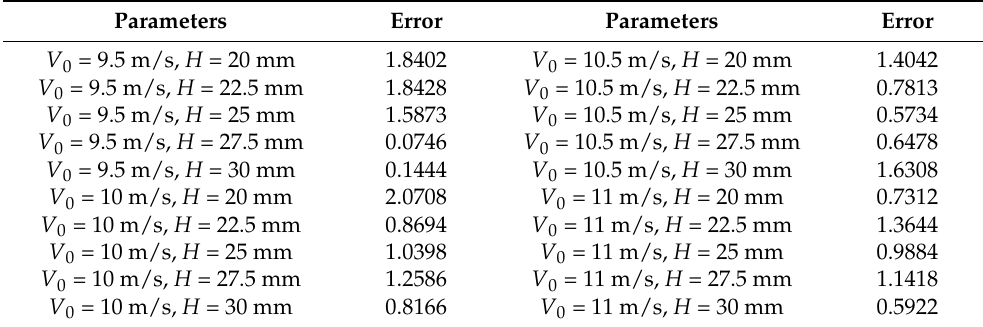
Table 3. Errors between numerical simulations and experimental data for the diameter of the formed surface.